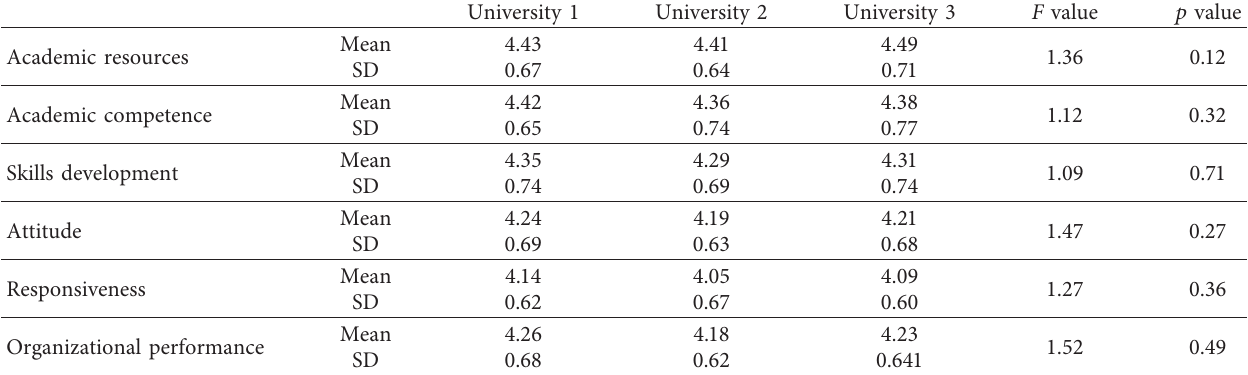
Table 3: Descriptive statistics and ANOVA results for academic service quality and organizational performance.